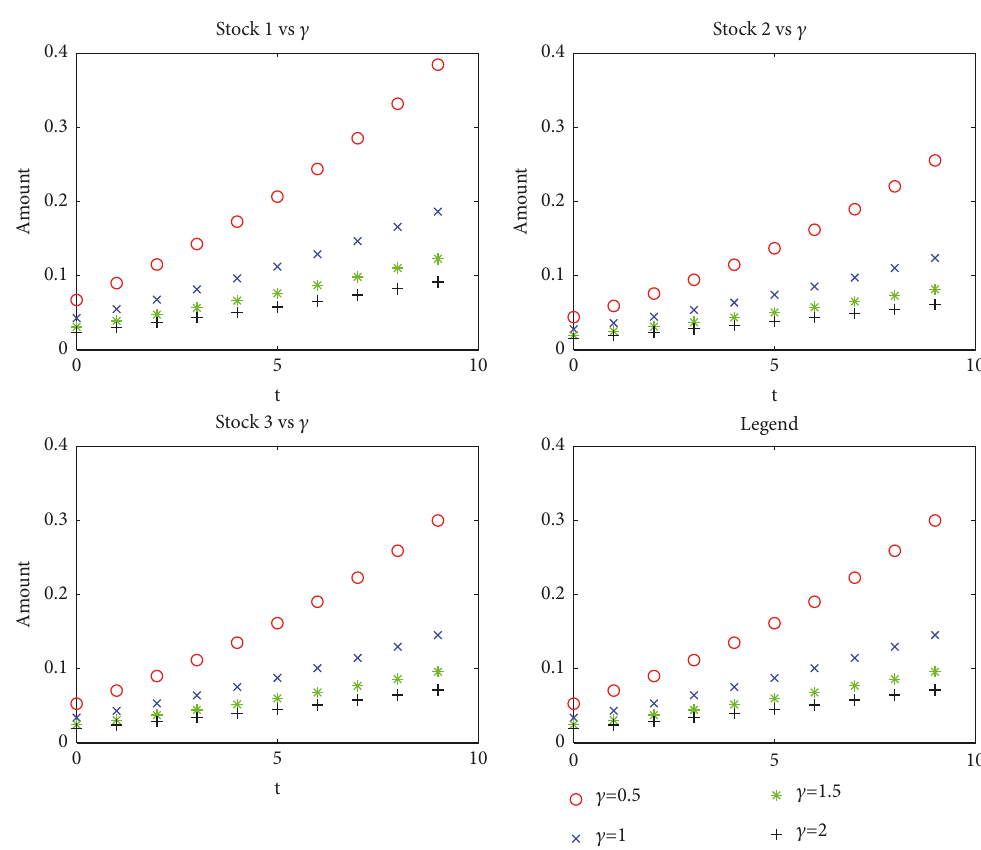
Figure 1: Equilibrium strategies under different risk aversion